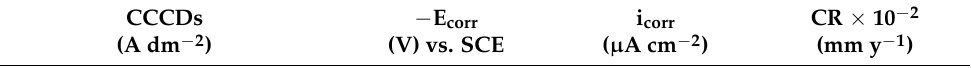
Table 3. Corrosion rates of multilayer coatings, having 10 layers each, developed using square and triangular current pulses at different sets of CCCDs.